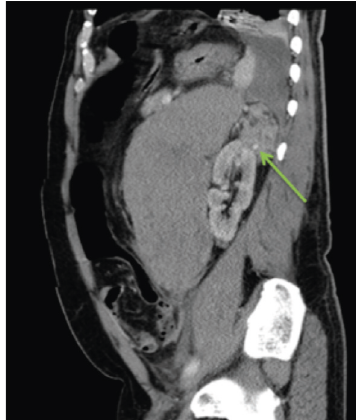
Figure 3: Green arrow shows a contrast extravasation consistent with active